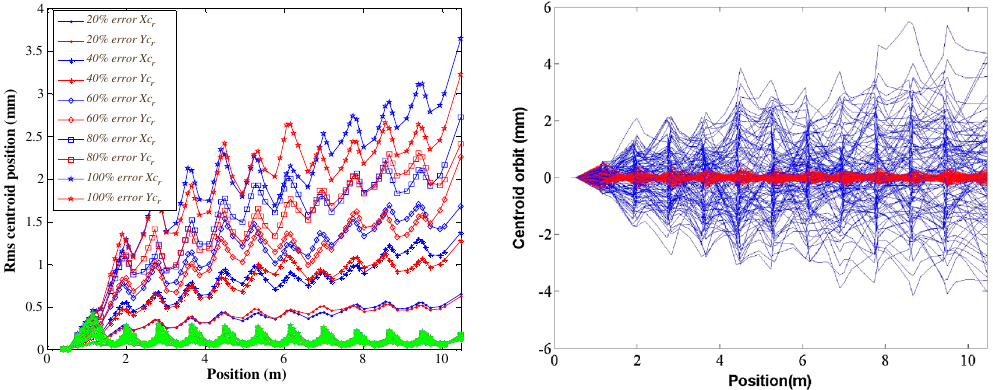
FIG. 32. Simulation results with different schemes in the Spoke012 section (left: rms centroid errors with different alignment error strength, green for after correction; right: centroid trajectories, blue for before correction, red for after correction).